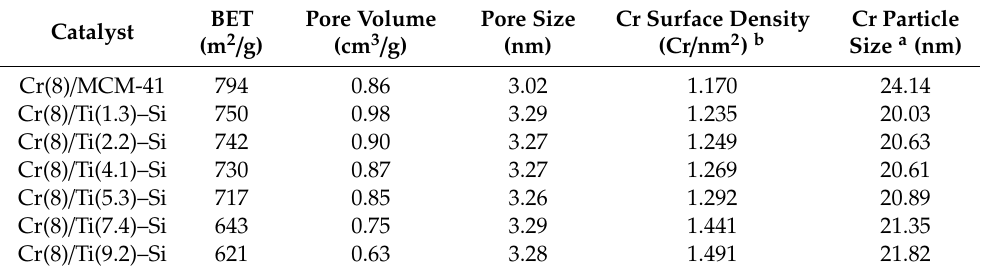
Figure 3. ( A ) N 2 isotherms and ( B ) pore size distribution of Cr(8) / MCM-41 and the Cr(8) / Ti(x)–Si catalysts prepared with varying titanium content, wt %. Textural properties of the MCM-41, Cr(8) / MCM-41, Ti(x)–Si nanocomposite and Cr(8) / Ti(x)–Si